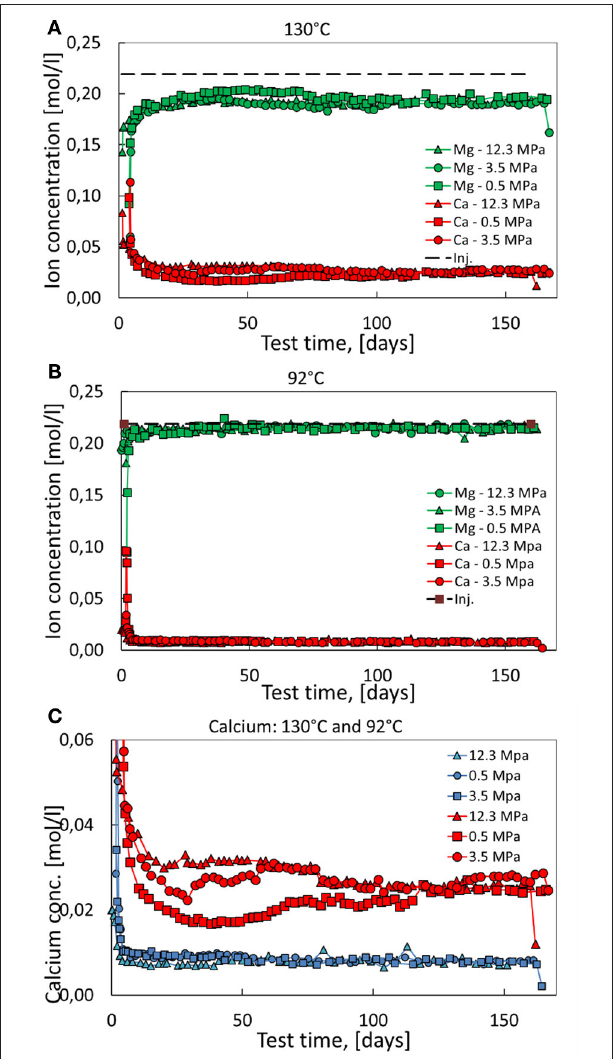
FIGURE 6 | Magnesium and calcium ion concentrations of the effluent at 92 ◦ C (A) and 130 ◦ C (B). The injected Mg 2 + -concentration is shown as dashed line at 0.219 mol. (C) Comparing the calcium production dynamics from the 92 ◦ C and 130 ◦ C